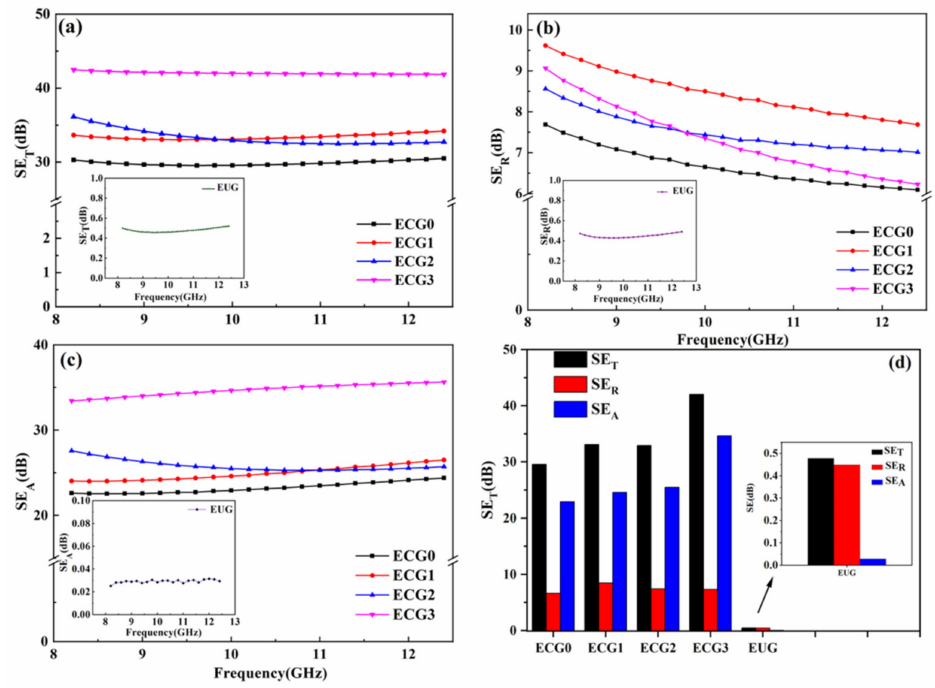
Figure 5. ( a ) EMI SE T ( b ) EMI SE R , ( c ) EMI SE A and ( d ) EMI SE T at 10 GHz of CNT/GNP/EUG